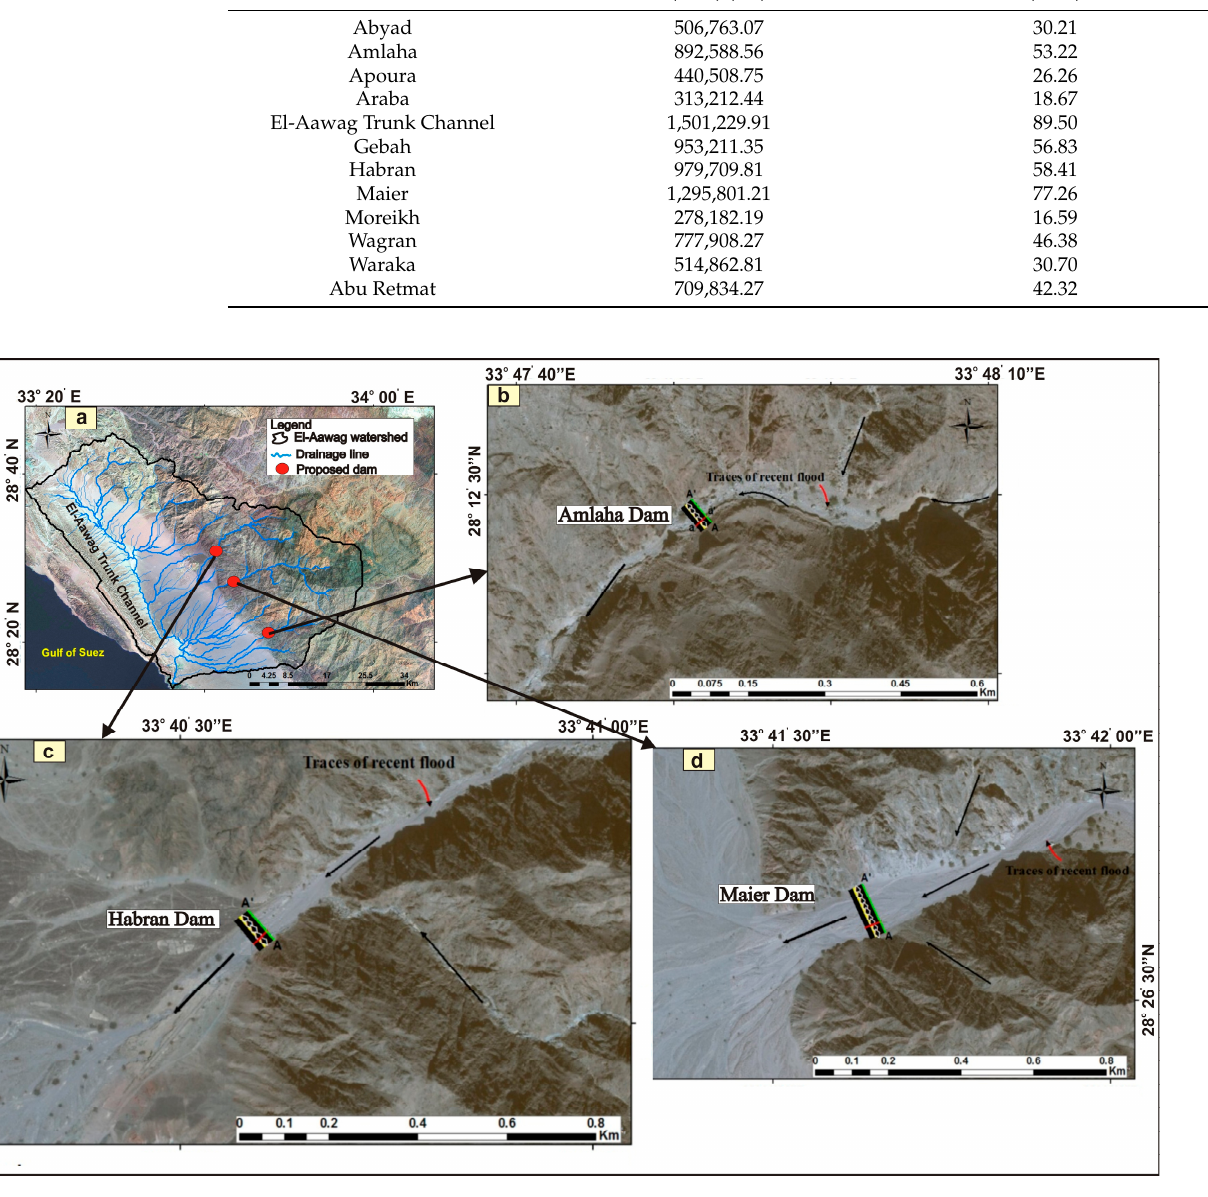
Figure 7. Site map of the proposed RWH system: ( a ) the proposed locations of El-Aawag watershed; ( b ) Wadi Amlaha dam; ( c ) Wadi Habran dam; ( d ) Wadi Maier dam.